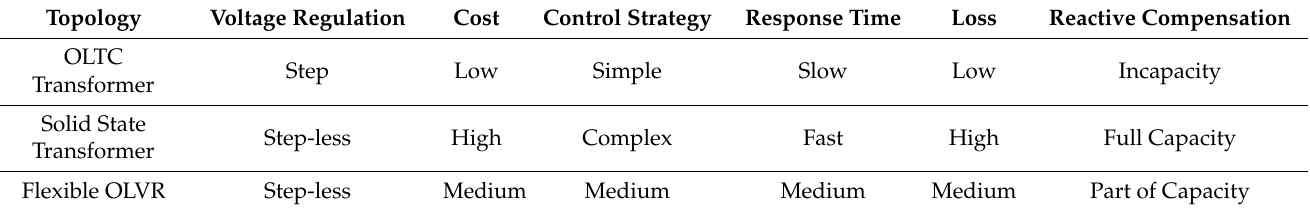
Table 1. Performance comparison table of the proposed structure and existing schemes.